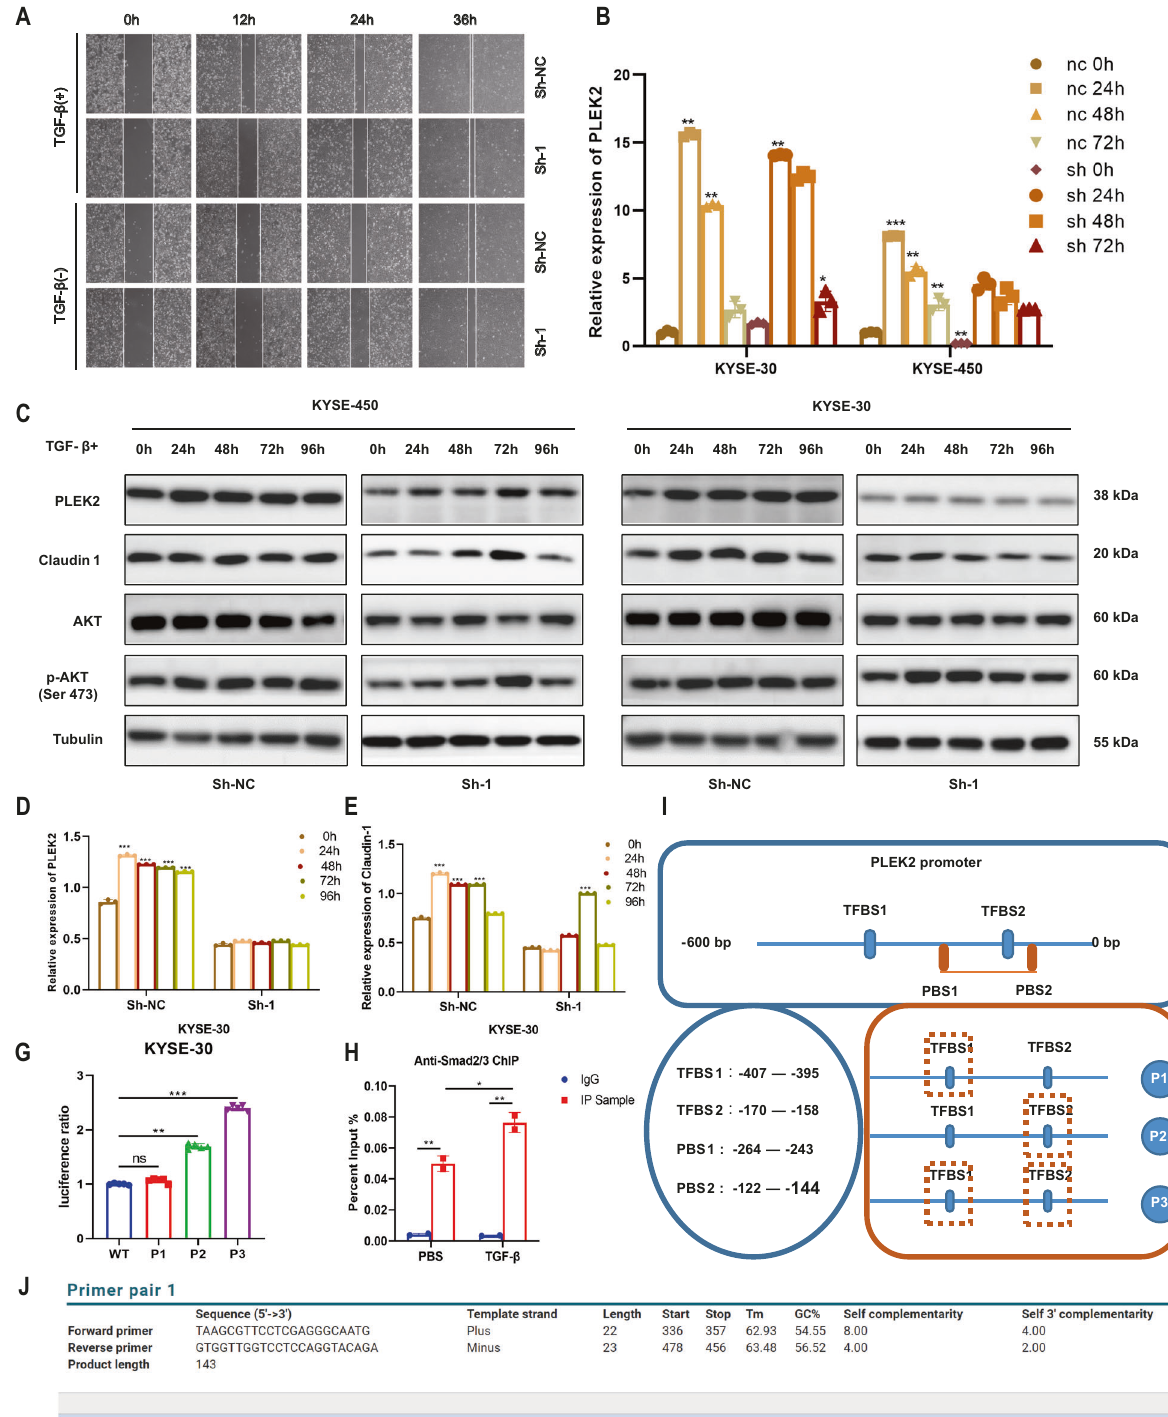
Fig. 5 TGF- β induces PLEK2 expression and its potential function. A Wounds of KYSE-30 cells with or without PLEK2 stably knockdown treated by TGF- β or PBS; Relative expression of PLEK2 in KYSE-30 with or without PLEK2 stably knockdown when treated by TGF- β in different time points. C Western blot analysis of PLEK2, Claudin-1, AKT, and p-AKT (Ser 473). Tubulin was used as control; D Histogram of expression of PLEK2 in KYSE-30 with or without PLEK2 stably knockdown when treated by TGF- β in different time points; E Histogram of expression of claudin-1 in KYSE-30 with or without PLEK2 stably knockdown when treated by TGF- β in different time points; G Luciferase of cells which were transferred into different plasmid containing different promoter regions; H ChIP assay showed interaction between Smad2/3 and PLEK2; I P1, P2, P3 sites (tested in luciferase assays) nearby PLEK2 gene; TFBS, transcription factor binding site; PBS, Primer Binding Site; J the ChIP primers location in PLEK2 promote. * P < 0.01; *** P < 0.01; *** P < 0.001.